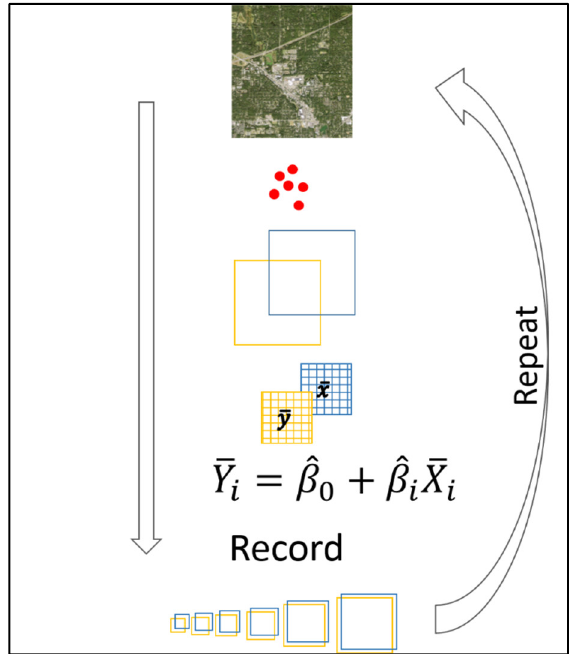
Figure 3. Visualization of Stage I simulations. A total of 200 sample locations (red points) were used to extract and calculate mean values from an image for different spatial extents around a point before and after a spatial shift was introduced (yellow and blue squares). Values were then regressed against one another to determine the impact of co-registration errors. This process was performed for each image used in the study.